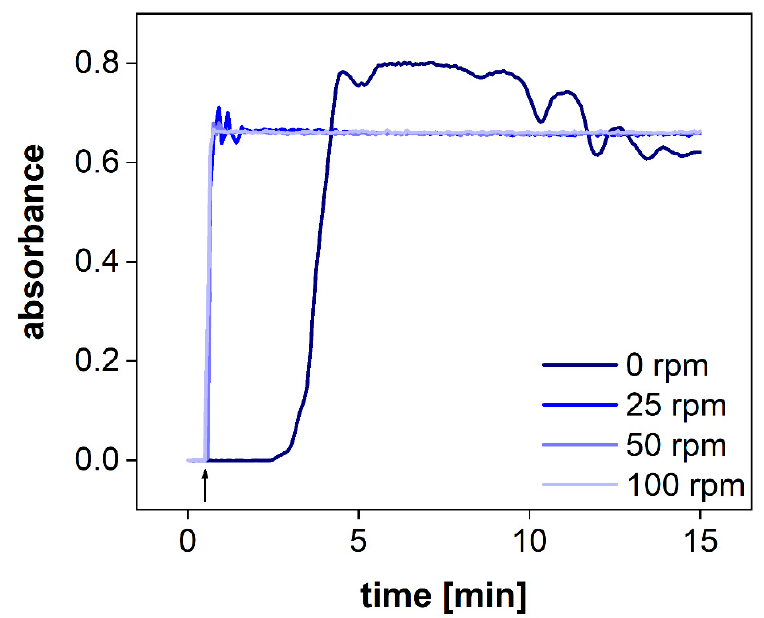
Figure 5. UV-Vis measurements of the acceptor compartment with an online dip probe at 283 nm at different stirring rates. The arrow denotes that the idebenone solution was spiked into the acceptor compartment.